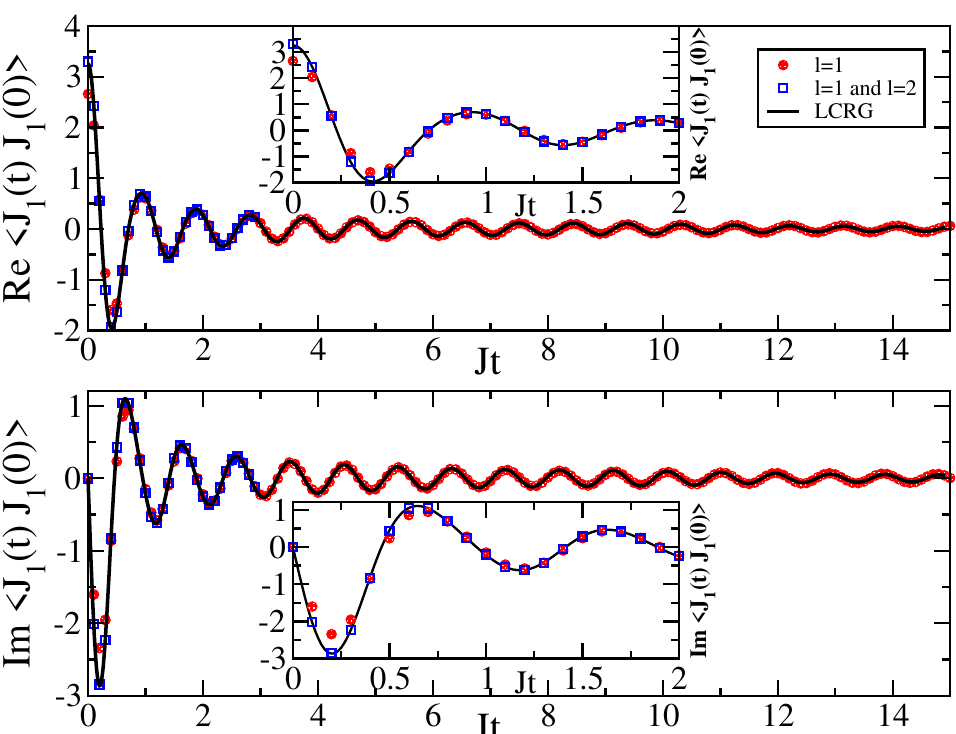
Figure 1: The real and imaginary contributions of the (cid:96) = 1 term and of the sum of (cid:11) (cid:96) = 1 and (cid:96) = 2 terms to (cid:10) J ( t ) J for ∆ = 1.2 are compared to LCRG results. The 1 1 insets show that the (cid:96) = 2 contribution becomes negligible on this scale for tJ >